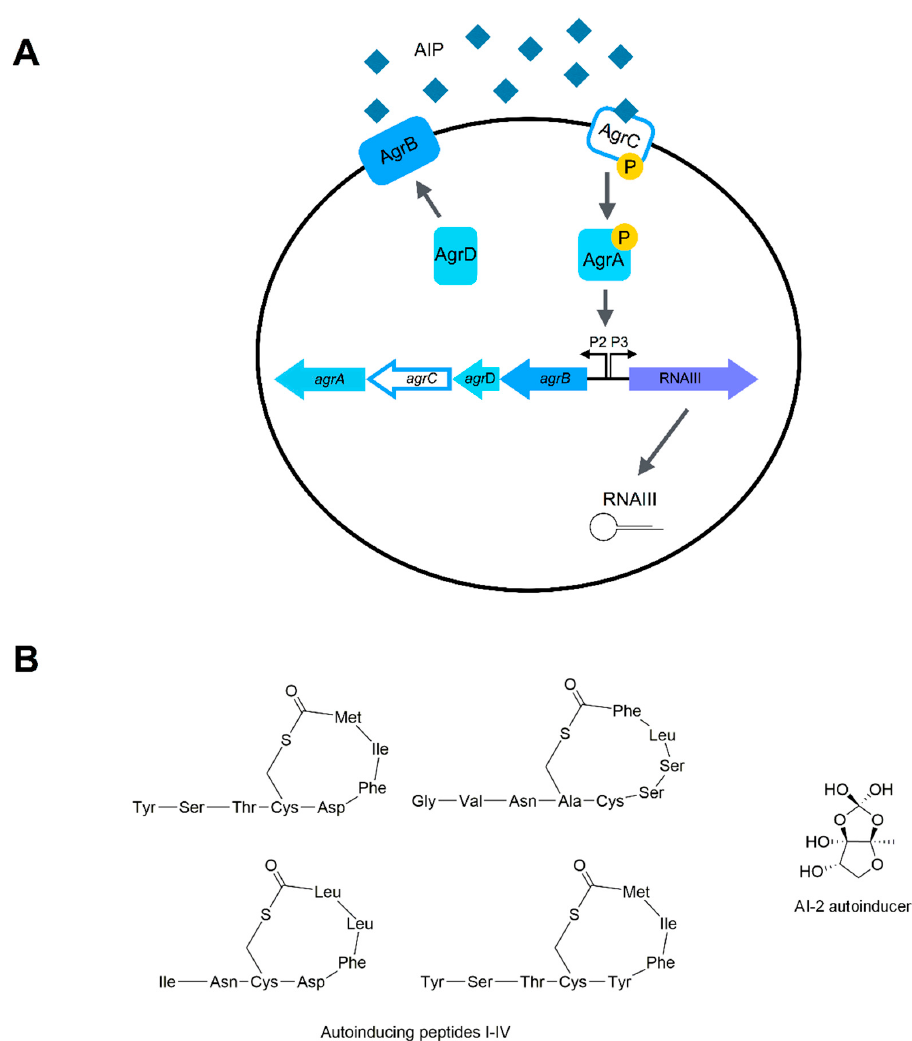
Figure 1. The Agr QS system of S. aureus . ( A ) The autoinducing peptide (AIP) is produced by AgrD and exported by AgrB. The two component system AgrC/AgrA is activated by AIP. AgrA binds the P2 and P3 promoter regions activating the agr quorum sensing feedback mechanism and RNAIII expression. ( B ) Chemical structures of autoinducing peptides I–IV and autoinducer-2 (AI-2)